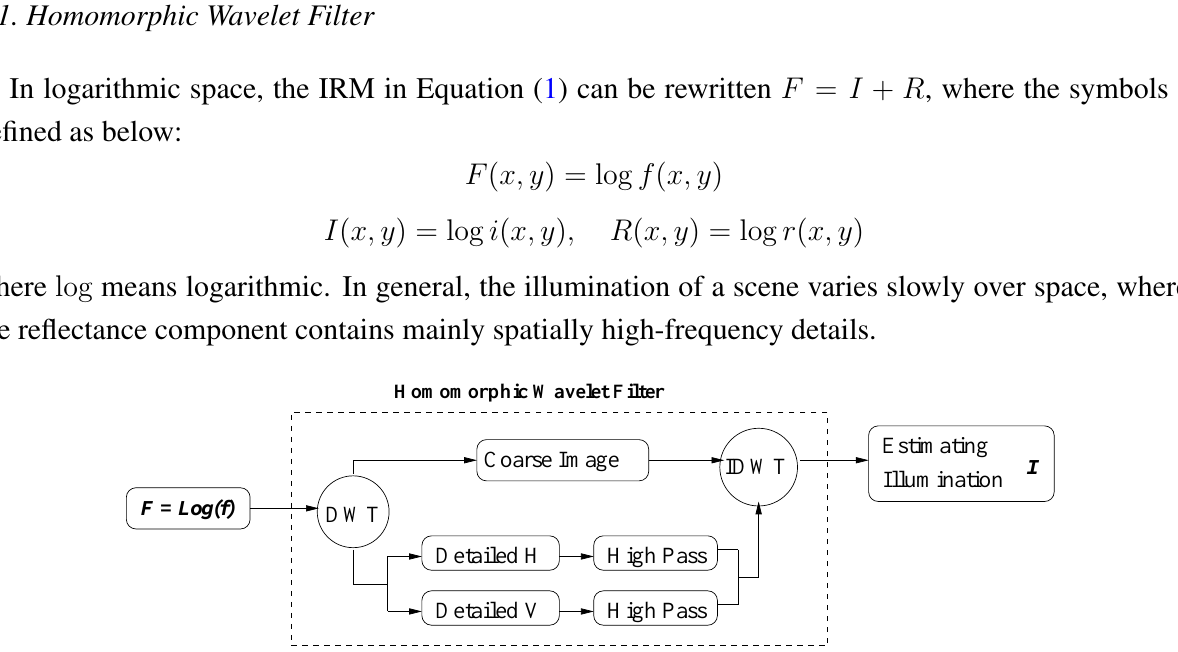
; and Detailed V: W 2 2 j 2 j